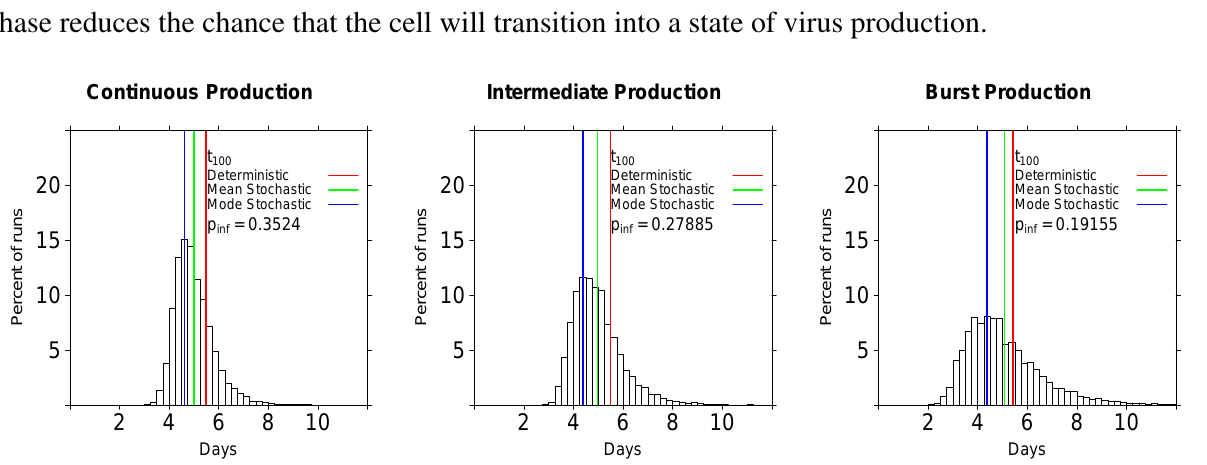
Figure 3. Distributions of times to 100 infectious viruses obtained using the Gillespie algorithm for the extended standard mathematical model of HIV/SIV dynamics (see Equations